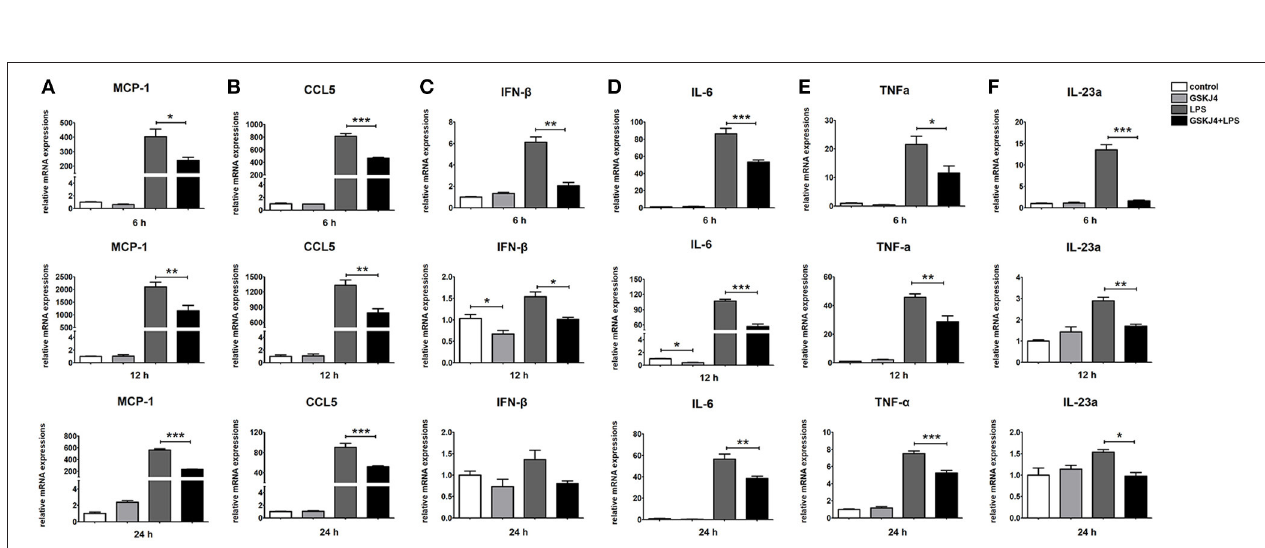
FIGURE 5 | GSKJ4 suppresses the expressions of inflammatory cytokines under LPS-stimulation in macrophages. Raw264.7 cells were pre-treated with or without GSKJ4 (4 µ mol/L) for 1h, followed by stimulation with LPS (100ng/mL). The mRNA expression levels of MCP-1 (A) , CCL5 (B) , IFN- β (C) , IL-6 (D) , TNF- α (E), and IL-23a (F) in Raw264.7 were determined by quantitative PCR at different time. Data are shown as mean ± SEM ( n = 3). * P < 0.05; ** P < 0.01; *** P <